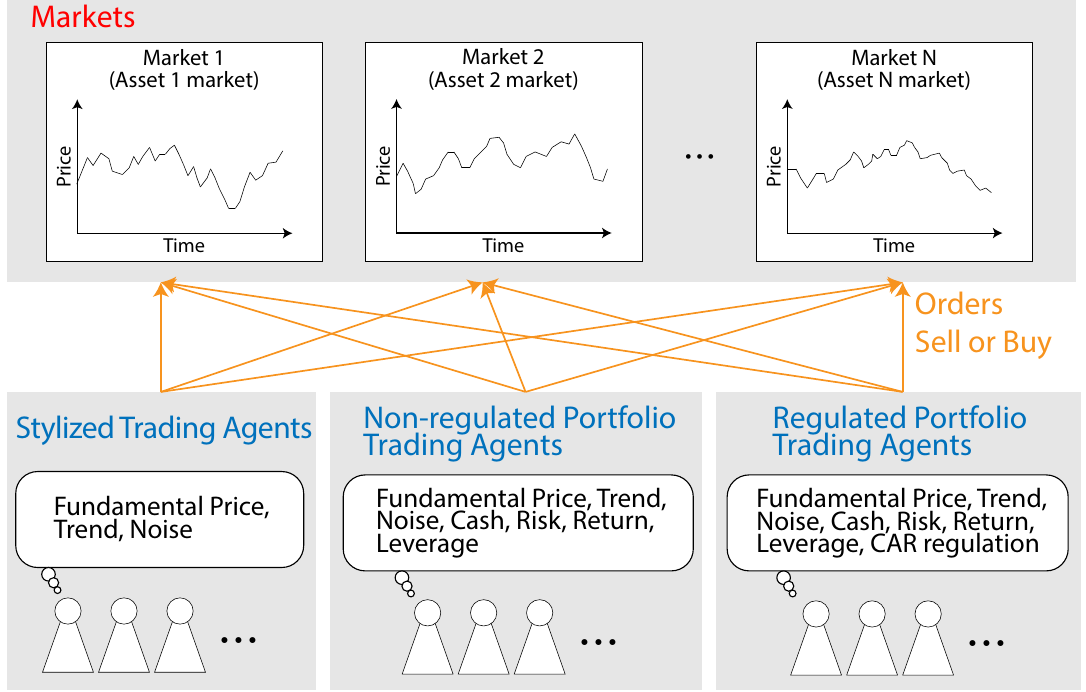
Figure 1. Model outline. The model consists of a number of markets in which three types of agent trade